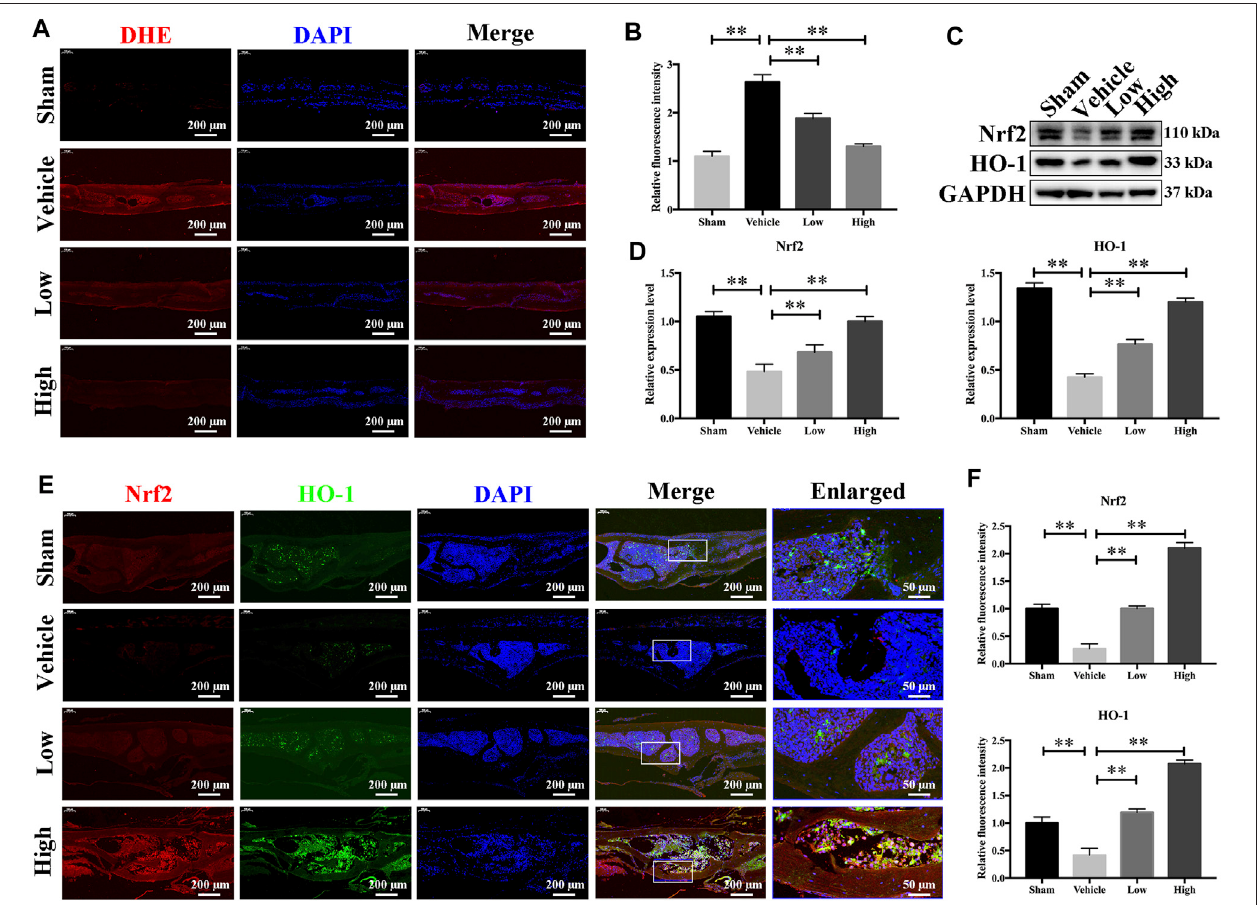
FIGURE 9 | JSH-23 reduces ROS production and enhances the expression of Nrf2/HO-1 in vivo . (A) Representative images of bone sections showing DHE fl uorescence in different groups. (B) Quanti fi cation of the DHE fl uorescence intensity of each group. (C) Proteins were isolated from bone tissues, and Nrf2/HO-1 expression was investigated using western blotting. (D) Quantitative analysis of the western blotting results. (E) Immuno fl uorescence double staining was performed to detecttheexpressionofNrf2andHO-1. (F) QuantitativeanalysisofNrf2andHO-1immuno fl uorescenceintensity.Thevaluesareshownasthemeans ± SDs,n (cid:1) 6; ** p <